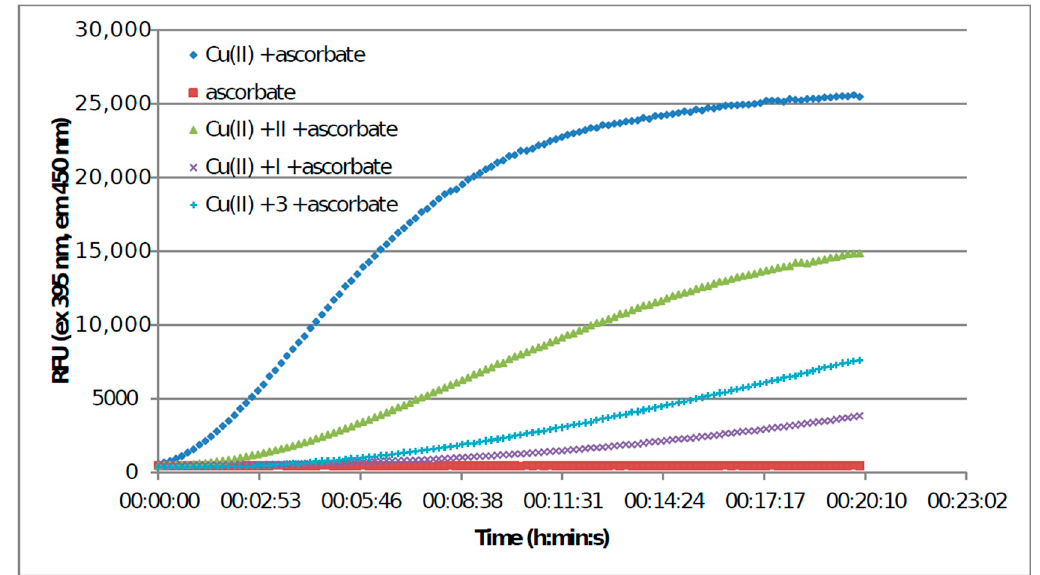
Figure 4. Fluorescence intensity of 7-hydroxy-CCA after incubation of CCA [100 µM] and Cu(II) [10 µM] with ascorbate [300 µM] ( ♦ ). Compound II ( ▲ ) [30 µM], I (×) [30 µM] or 3 (+) [30 µM] were added 30 min prior to ascorbate. Ascorbate ( ■ ) without Cu(II) was a negative control. All solutions except CuSO 4 (dissolved in Milli-Q water only) were prepared in KH 2 PO 4 [20 µM], NaCl [100 µM] buffer containing desferryl [1 µM], pH = 7.4.